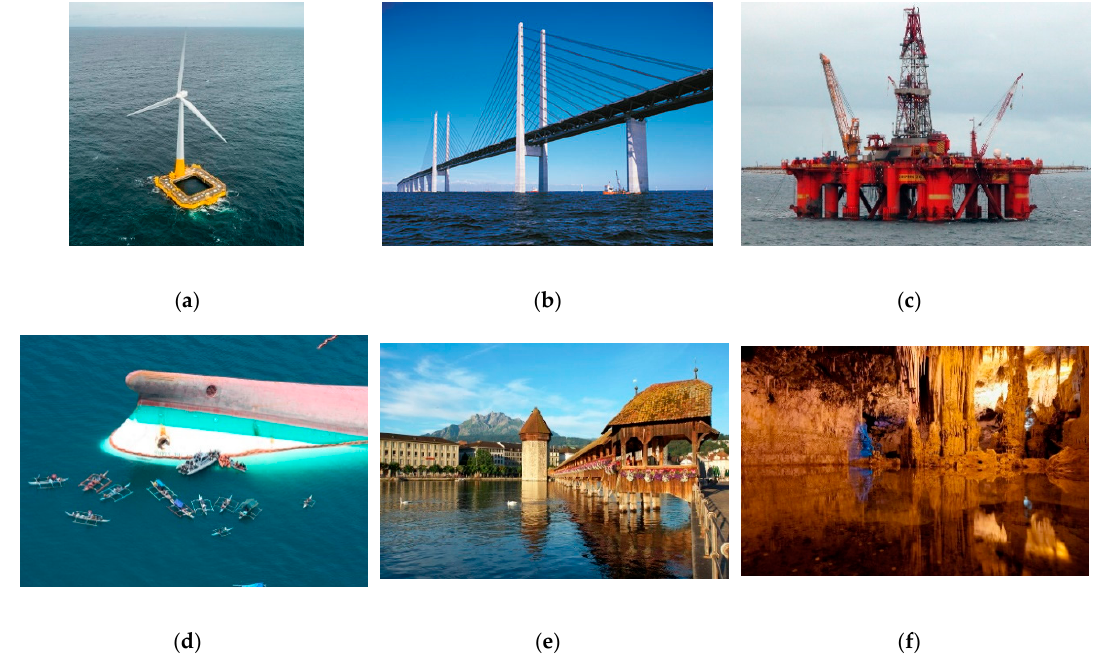
Figure 1. Examples of partially submerged manmade and natural objects that might need three- dimensional (3D) accurate measurements for documentation, inspection and monitoring